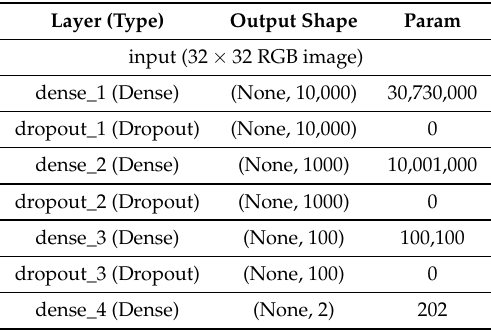
Table 3. Fully connected model configuration.